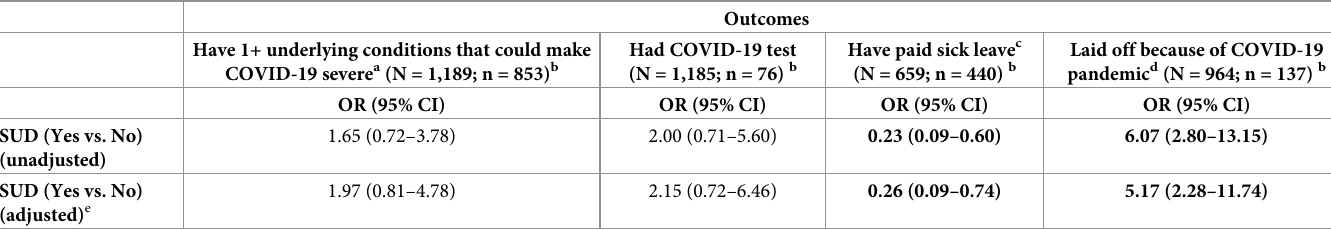
Table 2. Crude and adjusted associations between substance use disorders and COVID-related outcomes, May 29-June 10, 2020.